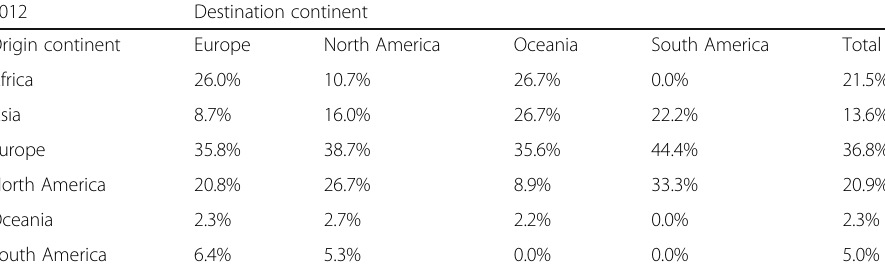
Table 4 Cross-continental movements of foreign-born Olympic athletes 2012 Destination continent Origin continent Europe North America Oceania South America Total Africa 26.0% 10.7% 26.7% 0.0% 21.5% Asia 8.7% 16.0% 26.7% 22.2% 13.6% Europe 35.8% 38.7% 35.6% 44.4% 36.8% North America 20.8% 26.7% 8.9% 33.3% 20.9% Oceania 2.3% 2.7% 2.2% 0.0% 2.3% South America 6.4% 5.3% 0.0% 0.0%